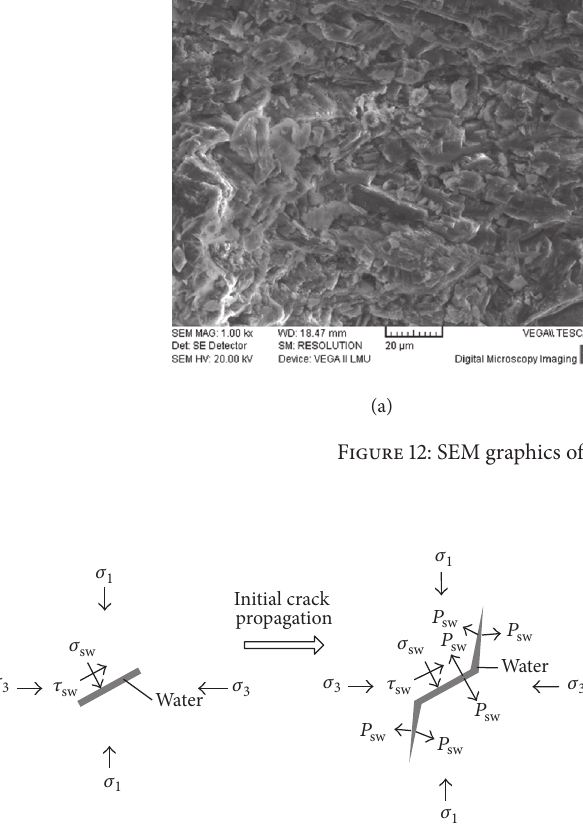
Figure 13: Crack sliding model under saturated states